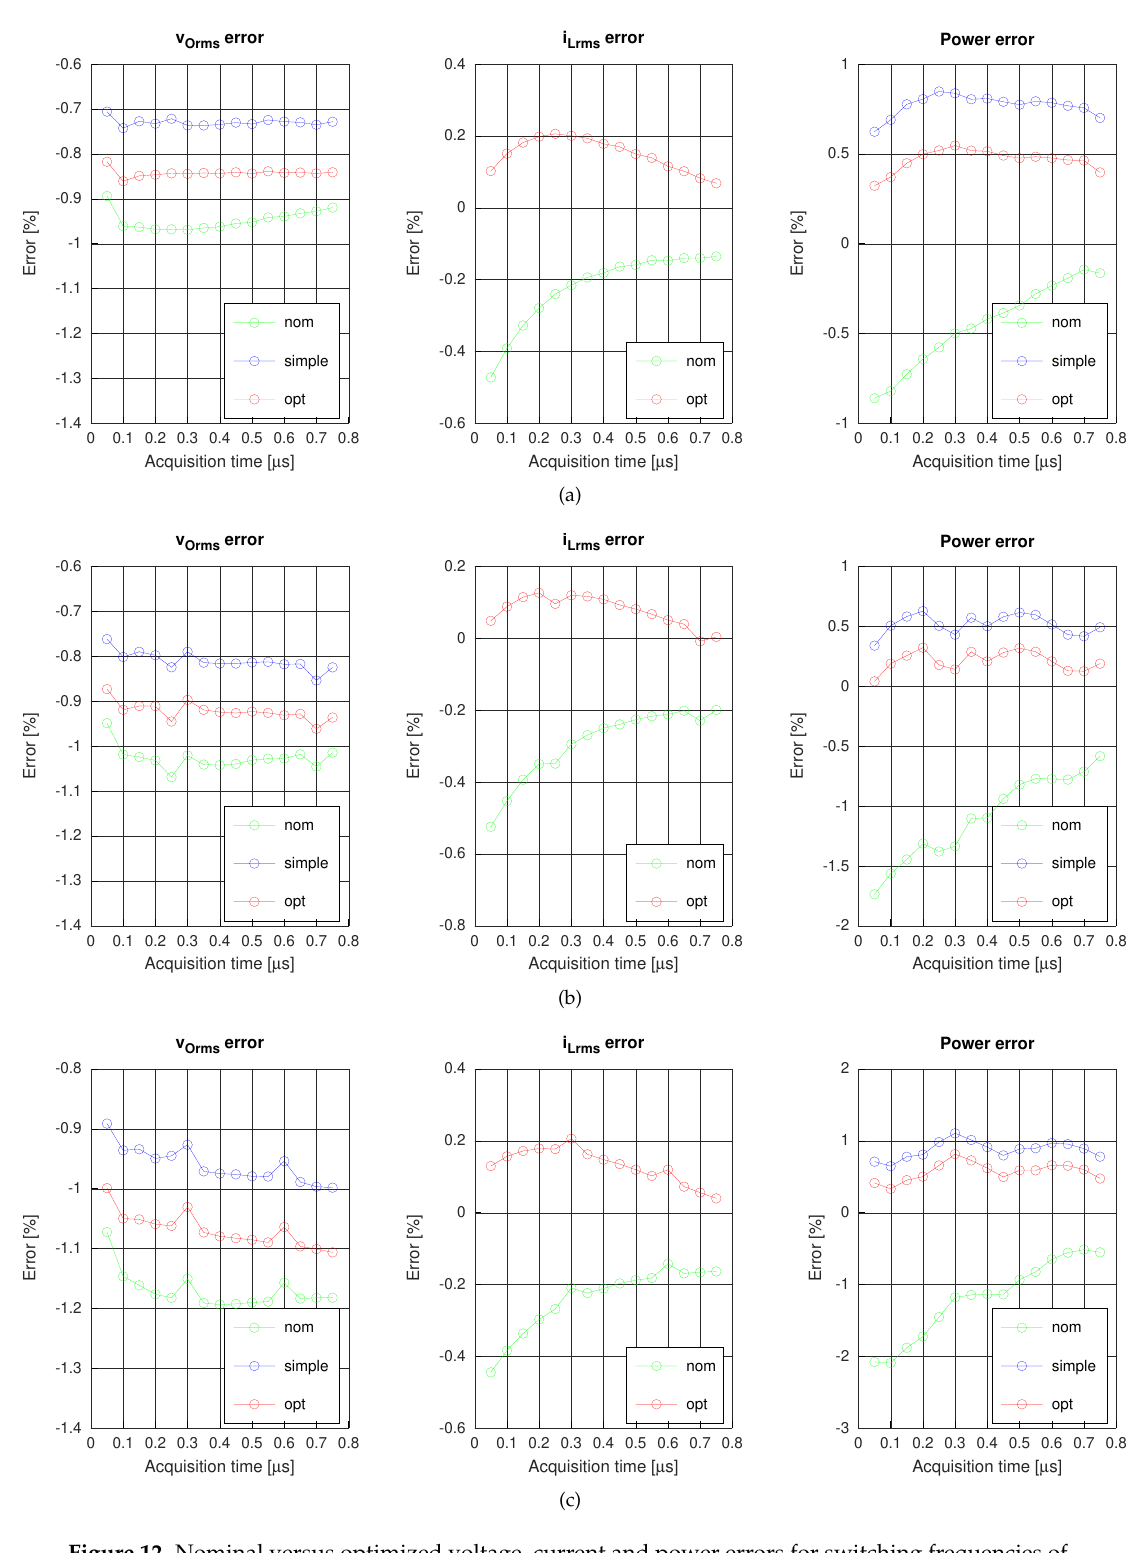
Figure 12. Nominal versus optimized voltage, current and power errors for switching frequencies of ( a ) 35 kHz, ( b ) 50 kHz, and ( c ) 70